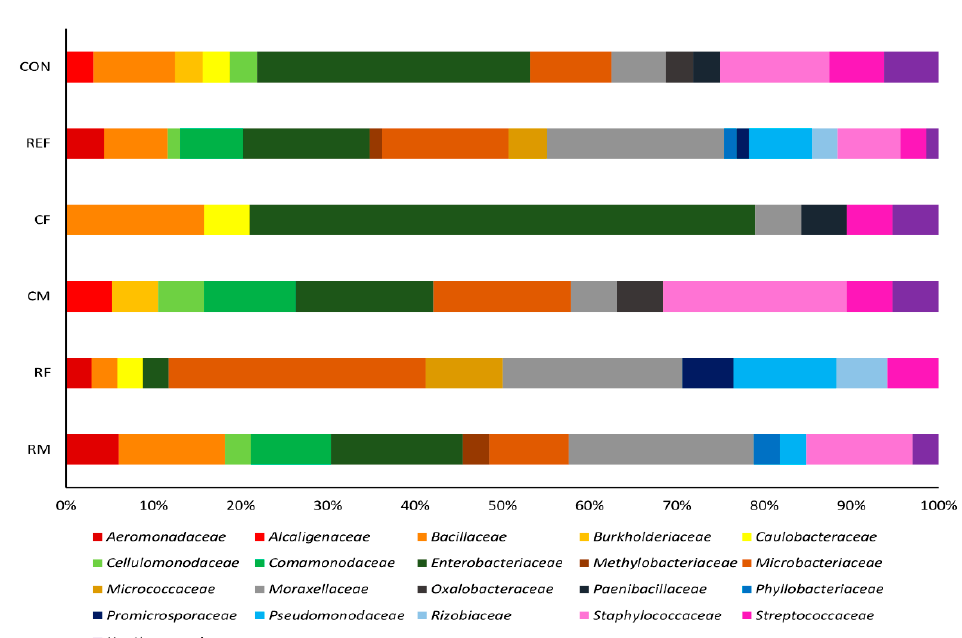
Figure 1. Cultivable microbiota composition of Pelophylax perezi skin at family level. The chart is divided into rows for (top to bottom): total samples from the metal-contaminated site (CON), total samples from the reference sites (REF), females (CF) and males (CM) frogs sampled at the metal-contaminated sites, and for female and male frogs sampled at the reference sites (RF and RM, respectively).